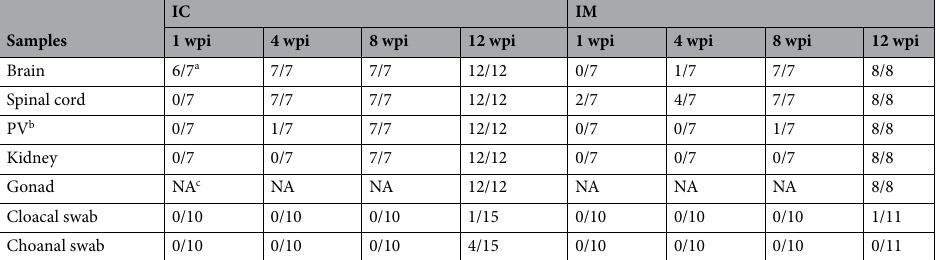
Table 2. Number of birds in the intracranial (IC) and intramuscular (IM) group, which tested positive for the ABBV-1N gene in a cohort of select tissues at 1, 4, 8, and 12 weeks post infection (wpi). a Indicates number of birds positive for that tissue/total number of birds tested for that tissue at that time point. b PV, proventriculus. c NA, the tissue was not available for analysis.